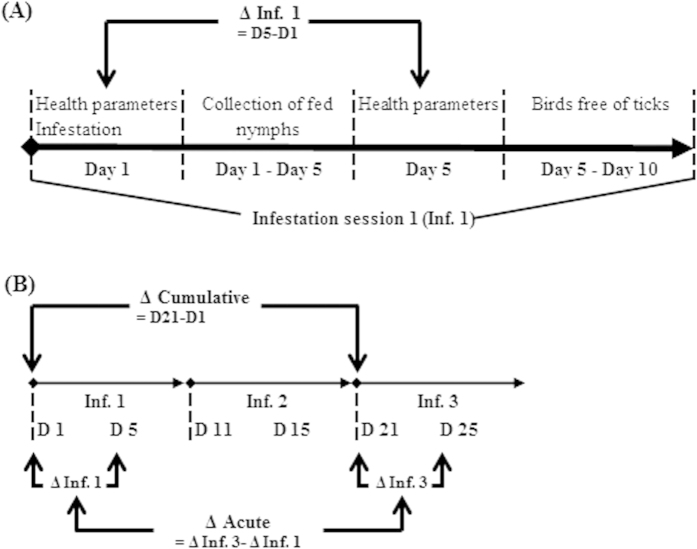
Schematic overview of the study design.(A) Actions taken during an infestation session (Inf.). “Δ Inf. 1” denotes the acute effect of the tick exposure (17 nymphs) on the birds’ physiology in session 1, i.e. the change in physiological parameters from prior to infestation to the moment that all ticks detached. (B) Schedule of successive infestation sessions. “Δ Cumulative” denotes the change in physiological parameters when birds had the opportunity to recover from the acute tick effects of Inf. 1 and Inf. 2 compared to the initial value in at day 1 (D1). “Δ Acute” denotes the change in acute responses between Inf. 1 and Inf. 3.